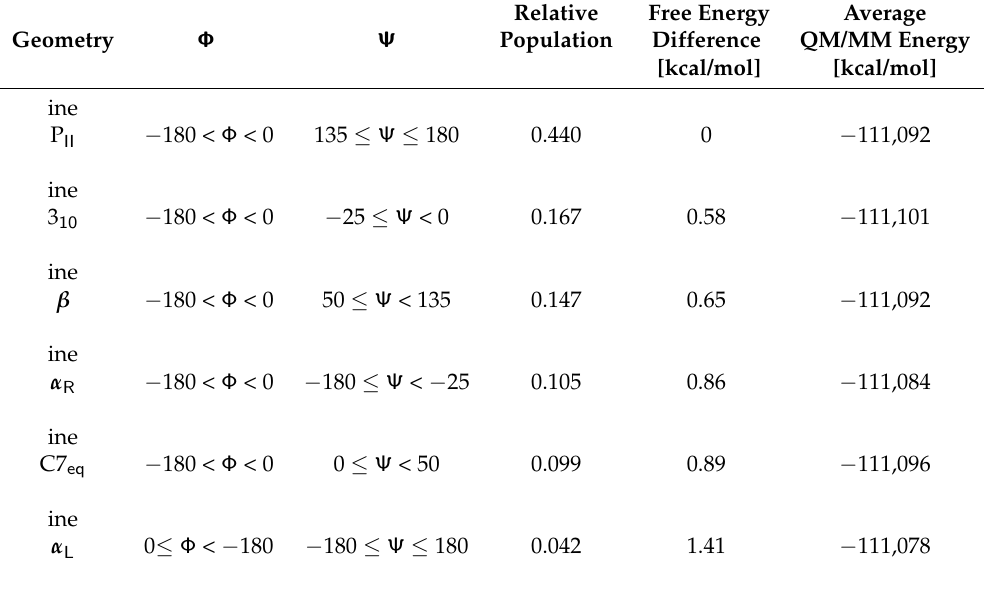
Table 2. The relative populations of 9-mer geometries are listed for six Φ - Ψ geometry basins in Ramachandran plot; free energy differences [kcal/mol], obtained from a population analysis F = − k B T ln ( N i / N ref ) , between the six sampled geometries are listed. The last column lists average QM/MM energies [kcal/mol] calculated from snapshots of the 9-mer and the ten nearest water molecules, extracted from the 200 ns MD simulation. The Φ - Ψ dihedral angles (given in